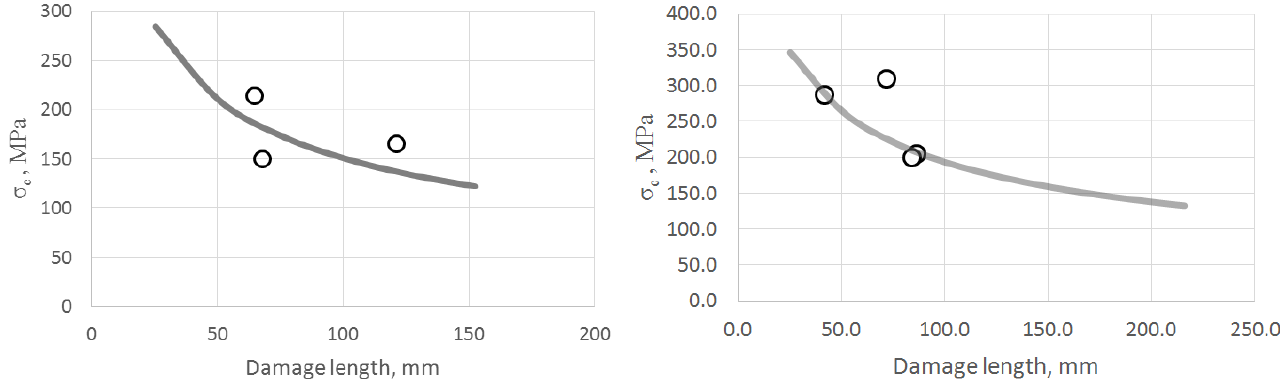
Figure 10: Computational results vs test data [15] (7075-T6 Transverse grain).